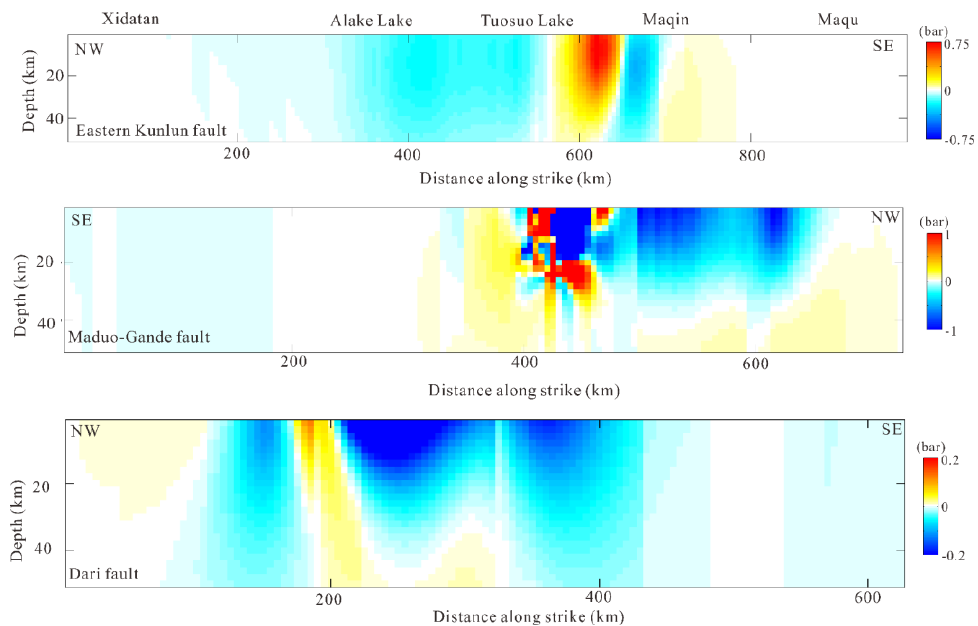
Figure 9. Static Coulomb failure stress (CFS) change caused by the Maduo earthquake on the three major faults.